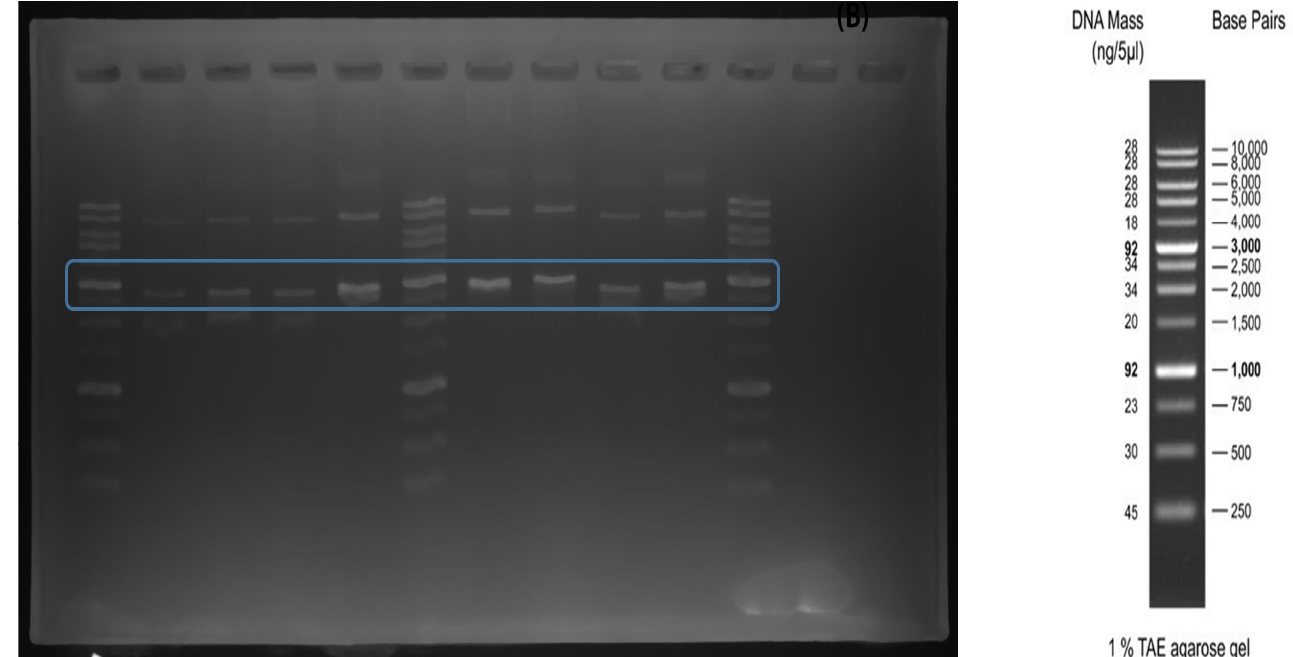
Figure 6. Electrophoresis results & 1 kb ladder. The targeted LegH sequence potentially identified 2500 bp (Blue at 2500 bp (Blue line).